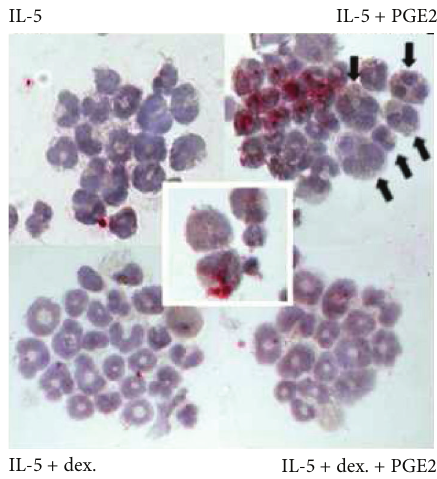
Figure 2: PGE2 upregulates and dexamethasone prevents iNOS expression in developing eosinophils. Bone-marrow cultures were established in the presence of IL-5, alone or associated with PGE2 (10 −7 M), dexamethasone (10 −7 M), or both. All cultures were main- tained for 2 days, before collecting cells for detection of iNOS by immunocytochemistry. Because (bright red) cytoplasmic staining for iNOS (insert) suffers interference from (brown) cytoplasmic staining for EPO, eosinophils were identified in this experiment by their donut-shaped nucleus [6] and homotypical aggregation pattern [9], after counterstaining with Harris’ hematoxylin. Arrow- heads in the upper right panel point to iNOS-negative cells showing nuclear changes (chromatin condensation/nuclear fragmentation) suggestive of apoptosis (compare with upper left and lower left panels). Insert shows details of cytoplasmic staining of cells exposed to IL-5 plus PGE2. Magnification 400x (under